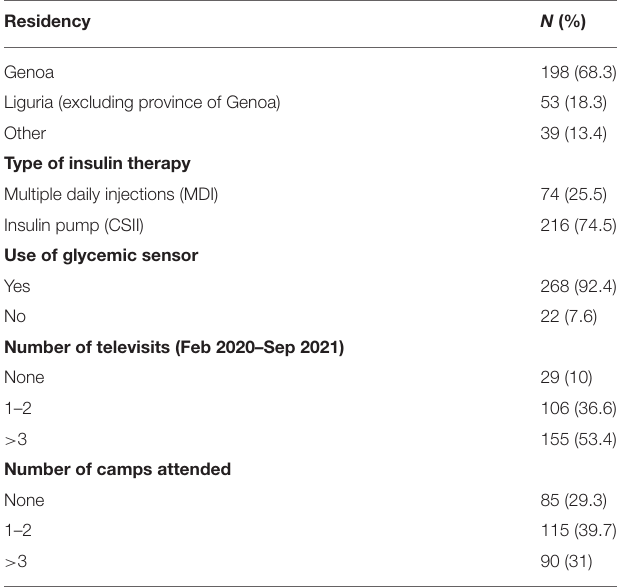
TABLE 2 | Clinical and personal characteristics of 290 patients who participated to the study. Residency N (%)